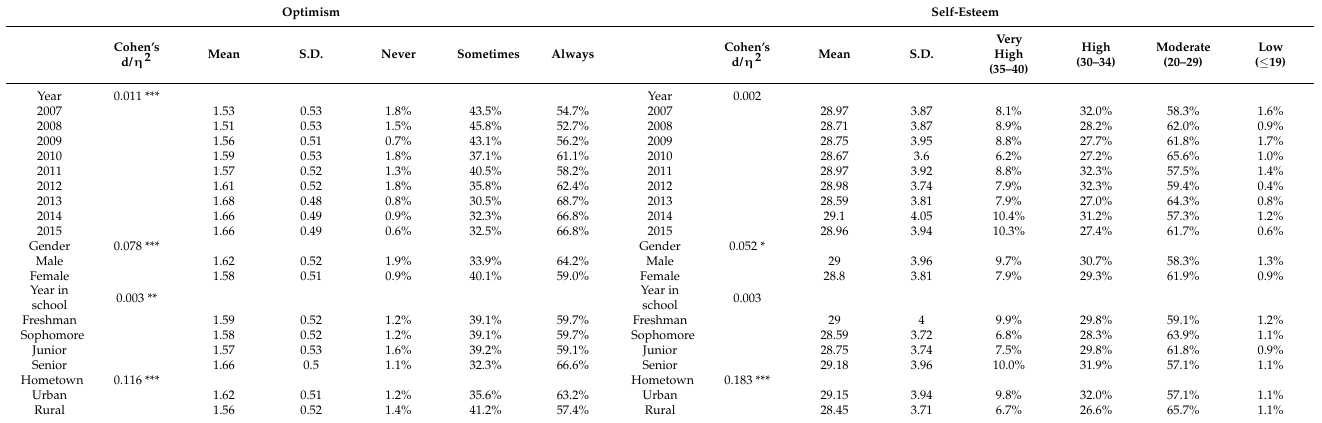
Table 4. Optimism and self-esteem in college students from 2007 to 2015.